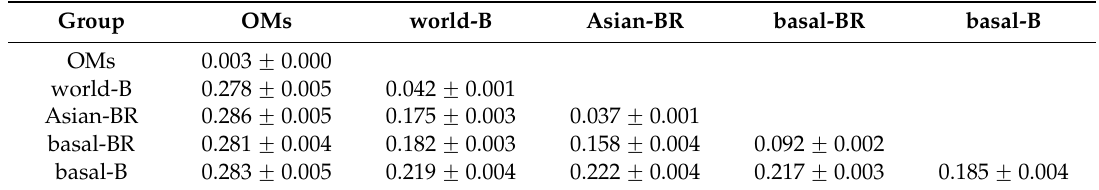
Table 5. The genetic distance of within and between populations and